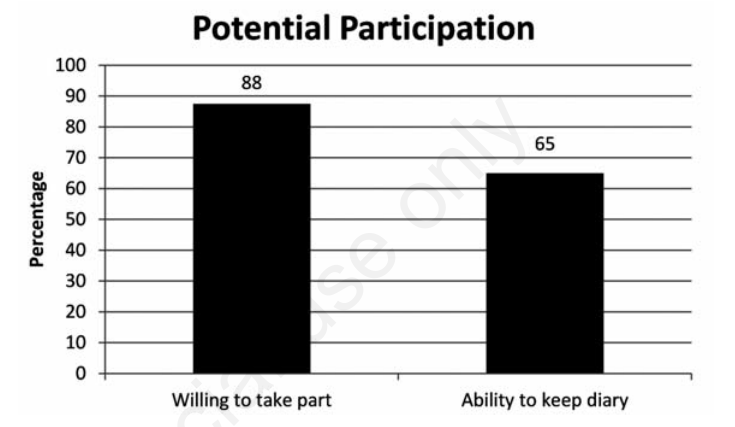
normalized.Figure 1. Participation rates for the proposed Randomized Controlled